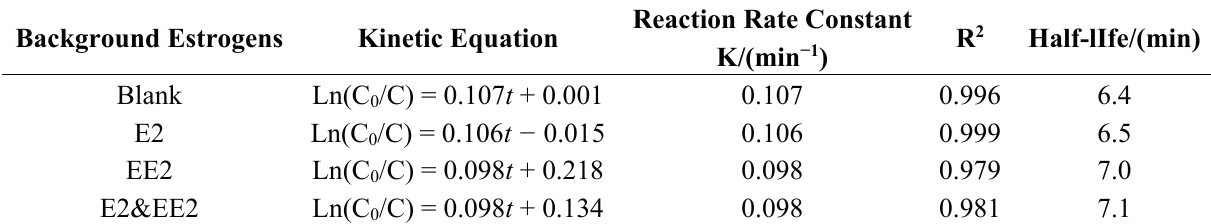
Figure 2. Degradation and first order kinetics of E1 under single and combined estrogen pollution. Table 1. Kinetic parameters of degradation of E1 under single and combined estrogen